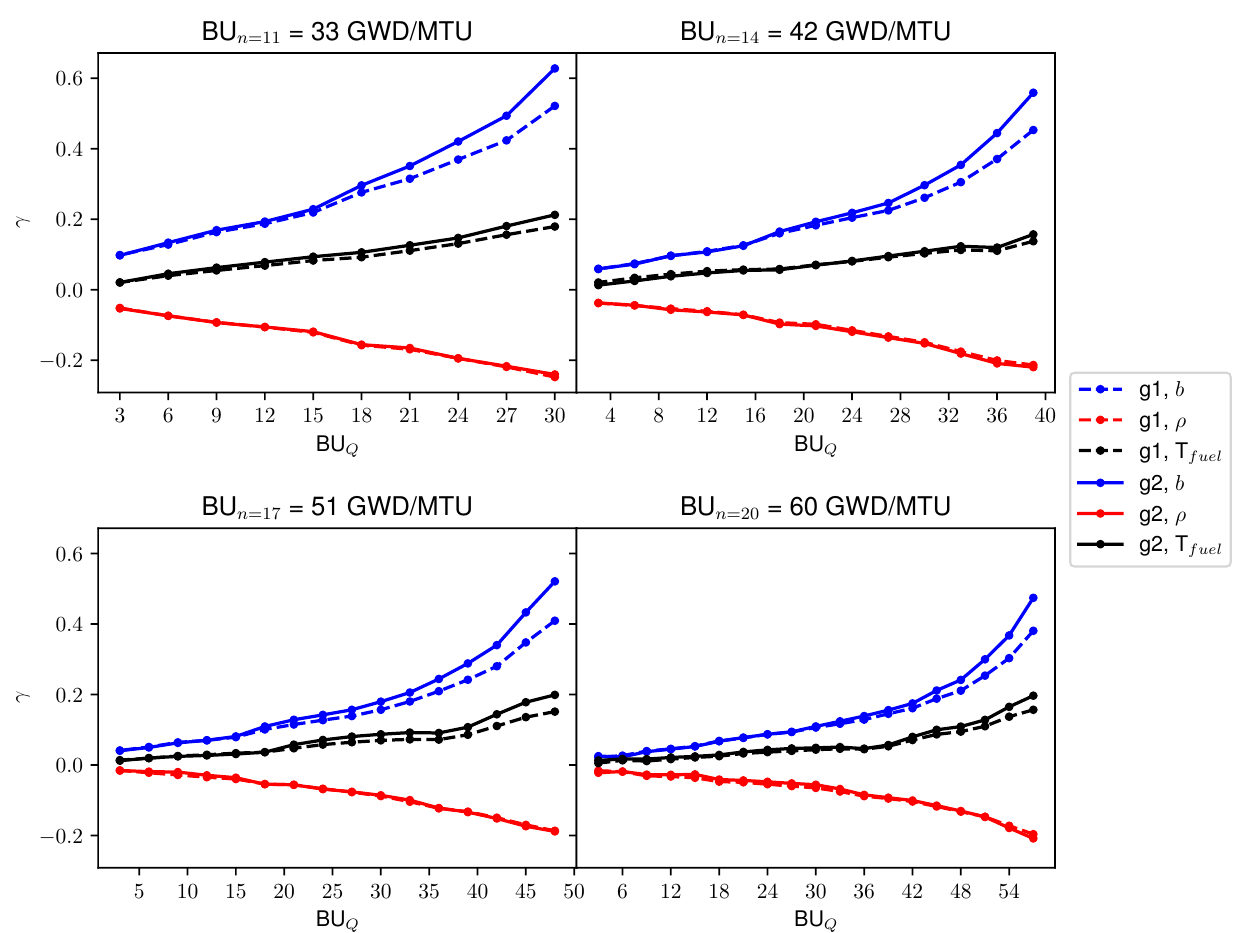
Figure 6. Sensitivities of Σ f to burnup-averaged values of state variables. Subfigure headers correspond to the bur- nup at which the HXS is calculated. In the legend, g# indicates the energy group of the HXS for which the sensitivity measure